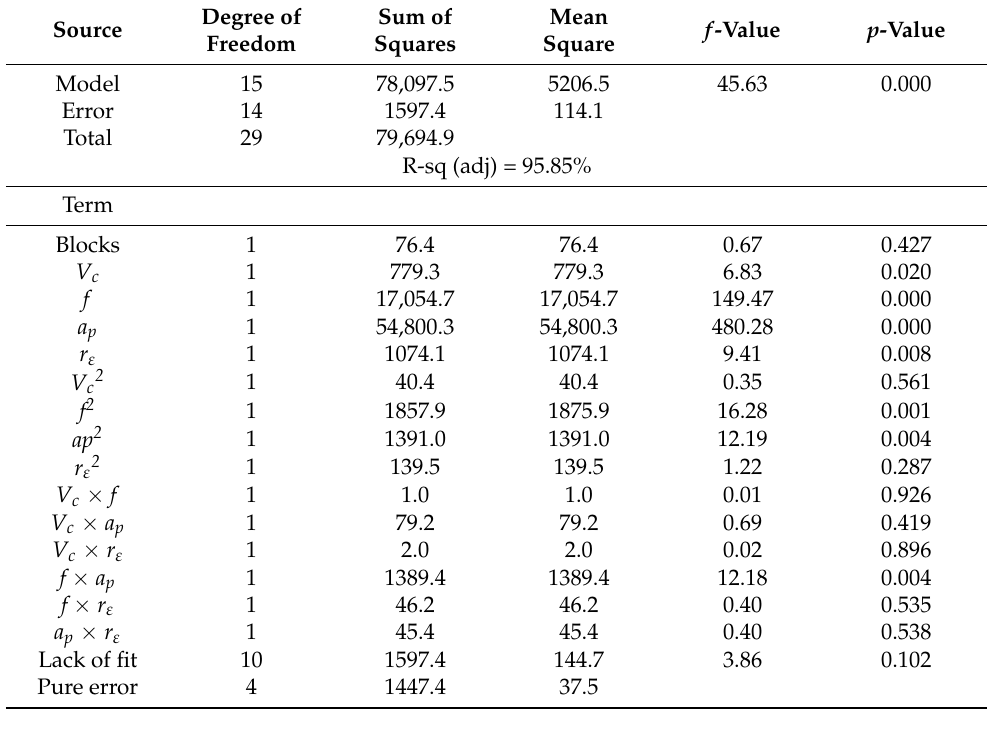
Table 5. ANOVA results for the resultant machining force based on the statistical model.